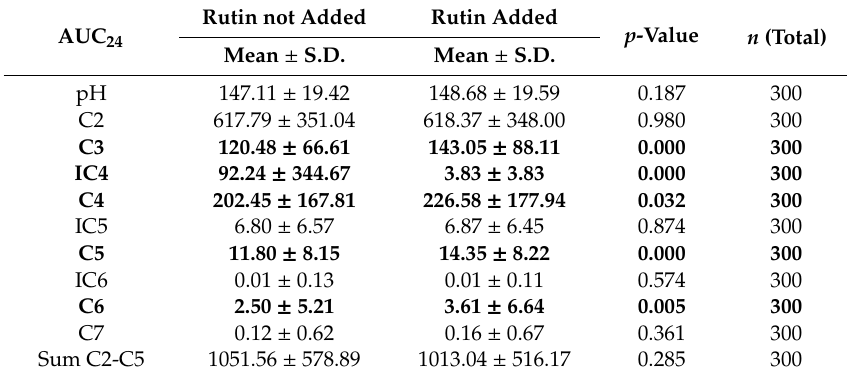
Table 2. E ff ect of rutin on short chain fatty acid profile expressed as AUC 24 irrespective of concentrations and type of fibre (ISP at concentration 0.8 g / 50 mL, PEC at 0.8 and 1.7 g / 50 mL, CEL, INU, RM at 0.8, 1.7 and 3.3 g / 50